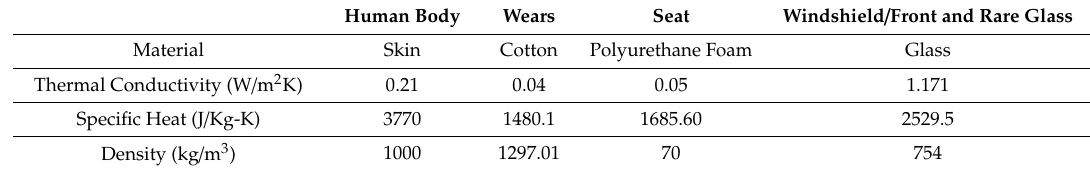
Table 2. Material properties for numerical analysis.